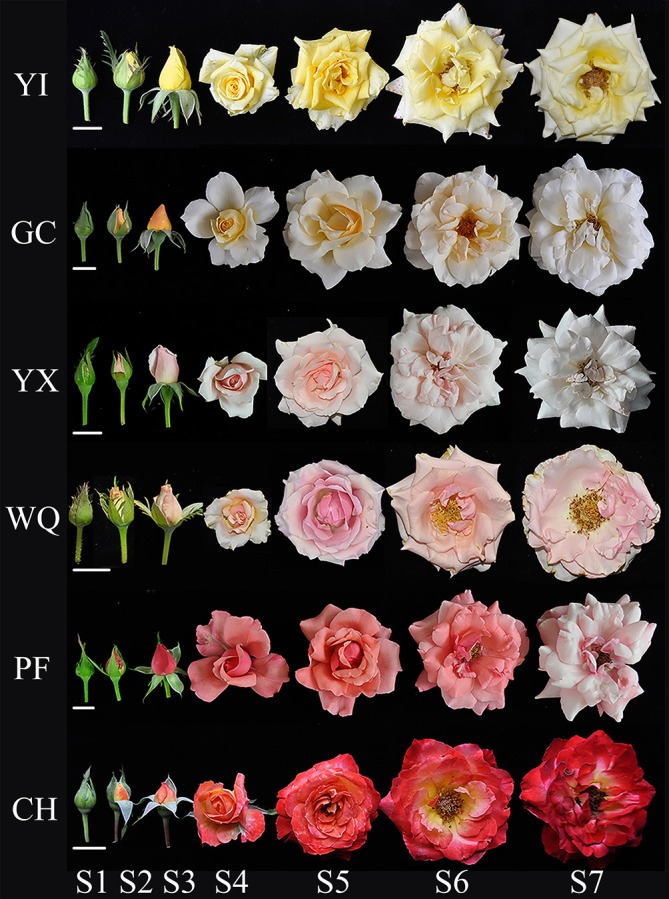
Flower phenotypes of six rose cultivars during flower development. Seven developing stages of rose flower: S1, unopened bud stage; S2, semi-opened stage; S3, fully-opened stage; S4, initial bloom stage; S5, full bloom stage; S6, bloomed stage; and S7, senescent stage. Bar = 2 cm.